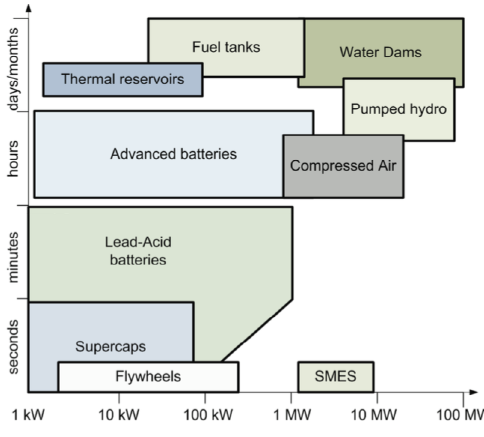
Fig. 4. Classi fi cation of storage technologies.